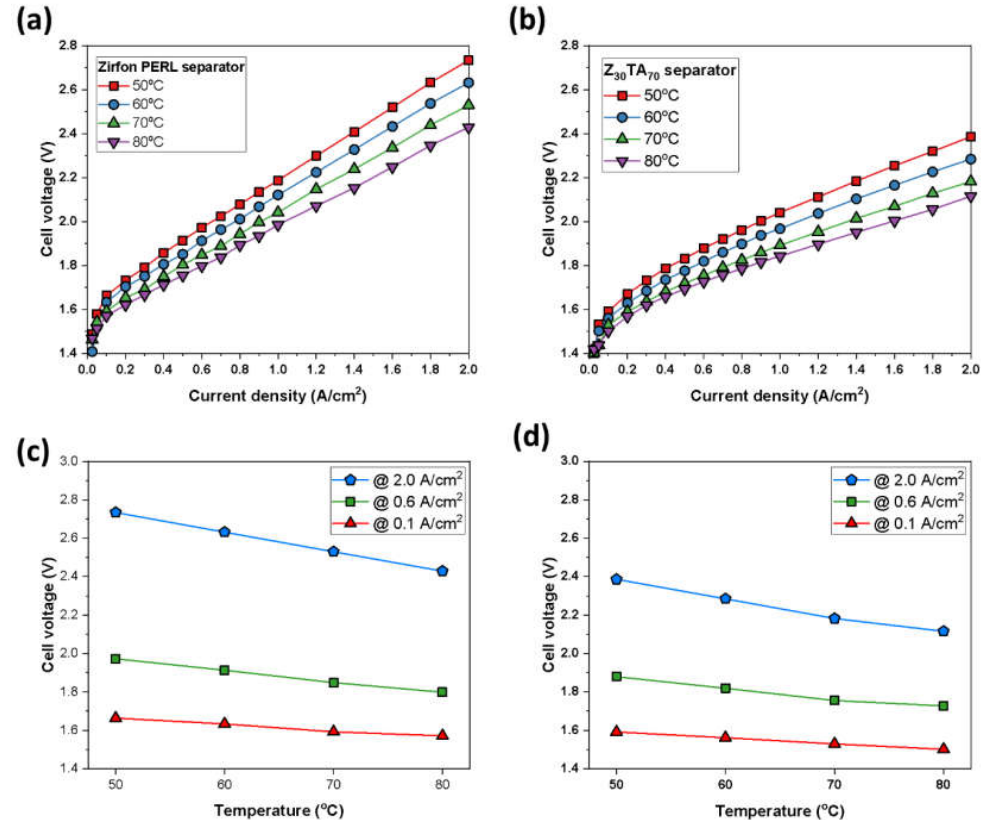
Figure 10. Polarization curves for an electrochemical cell using Raney nickel as the cathodic and Ni-Fe LDH as anodic electrode, respectively, at different temperatures ( a ) Zirfon ® and ( b ) Z 30 TA 70 separator membrane. Effect of temperature on cell voltage at different current densities ( c ) Zirfon ® and ( d ) Z 30 TA 70 separator membrane.